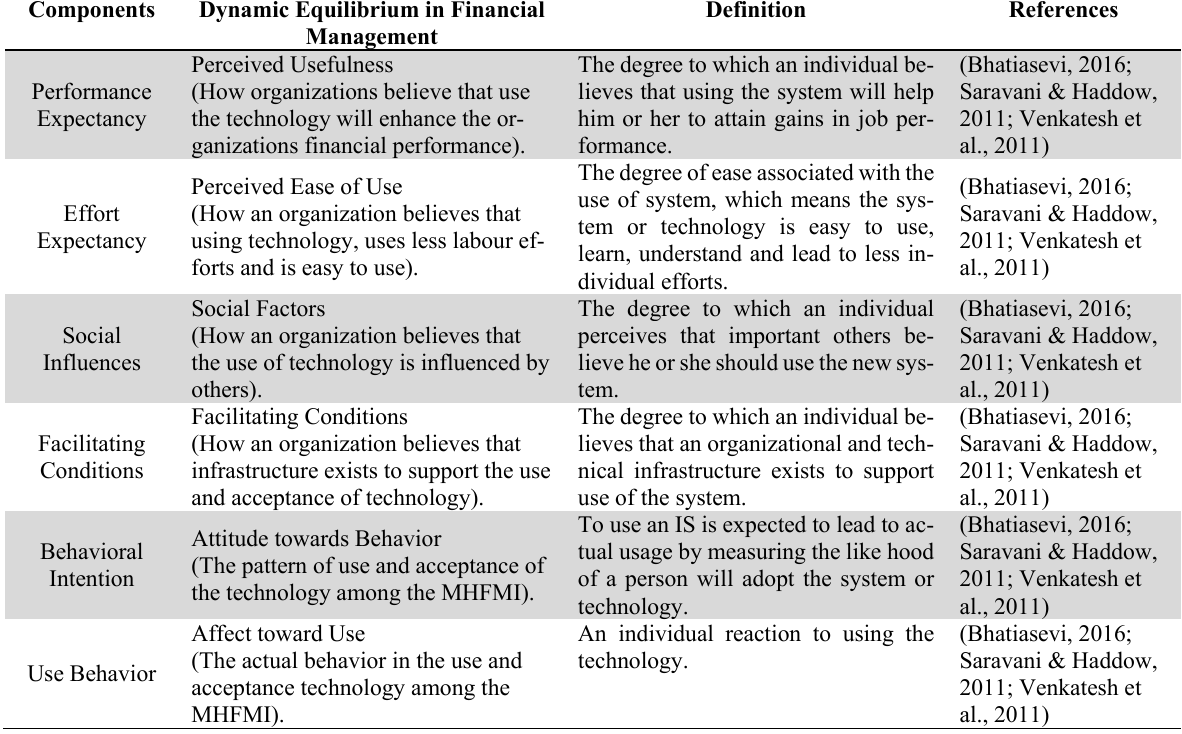
The UTAUT framework six